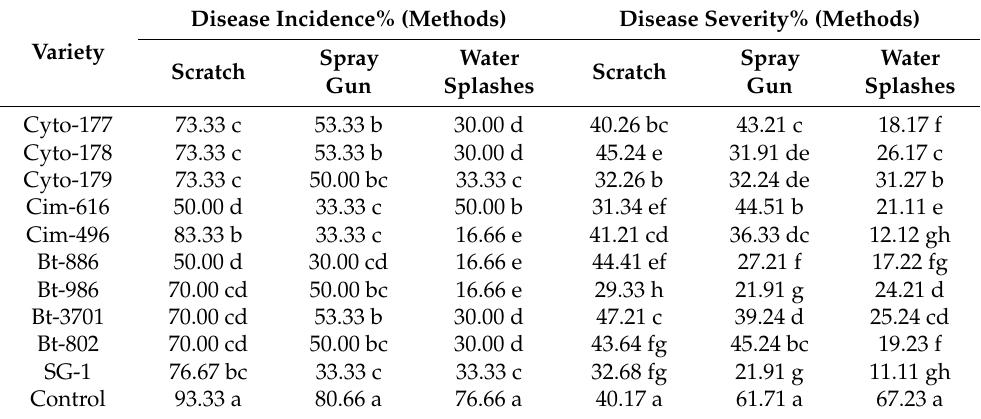
Table 2. Evaluation of cotton germplasm and its response against bacterium dispersal methodology under glasshouse